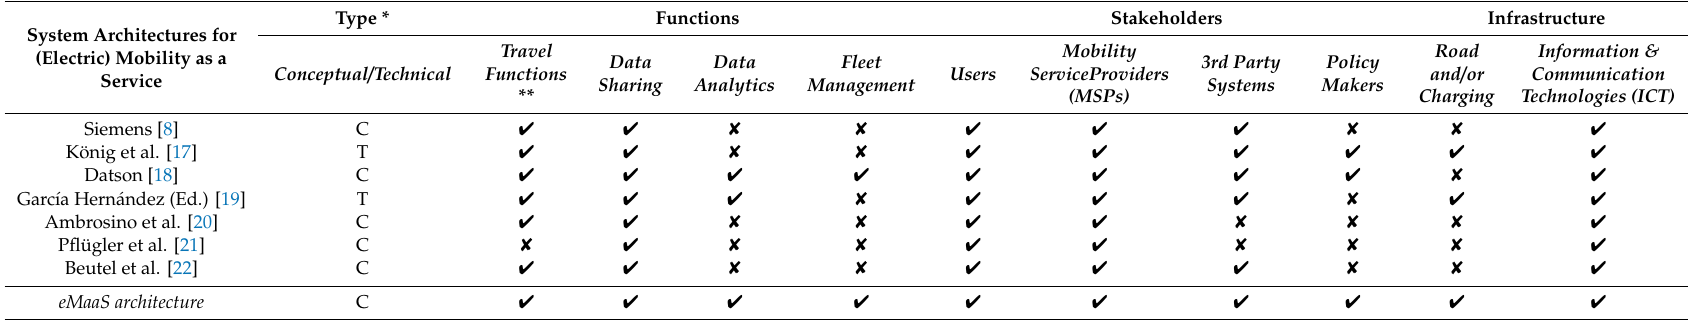
Table 2. Comparison between elements covered by MaaS system architectures found in literature and the eMaaS architecture proposed in this paper. System Architectures for (Electric) Mobility as